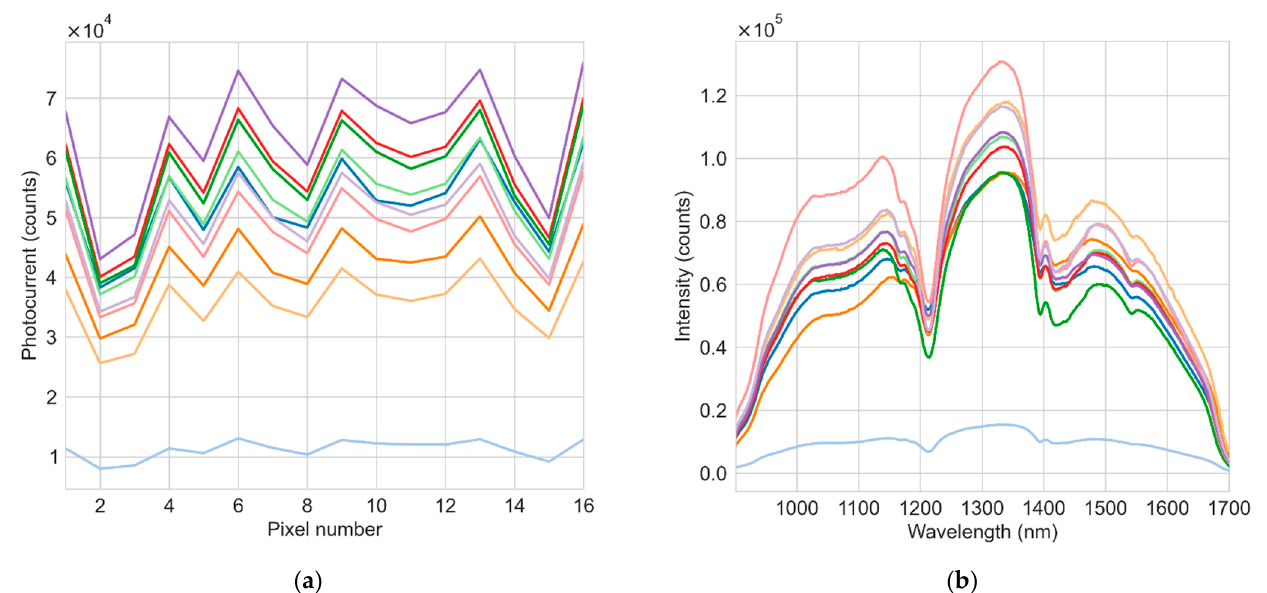
Figure A2. Representative measurements prior to normalization, of colored HDPE (type 2) samples taken by the SpectraPod ( a ) and NIRscan ( b ). The measurement with the lowest photocurrent and intensity resulted from the dark blue sample (circled in red in Figure A1b).